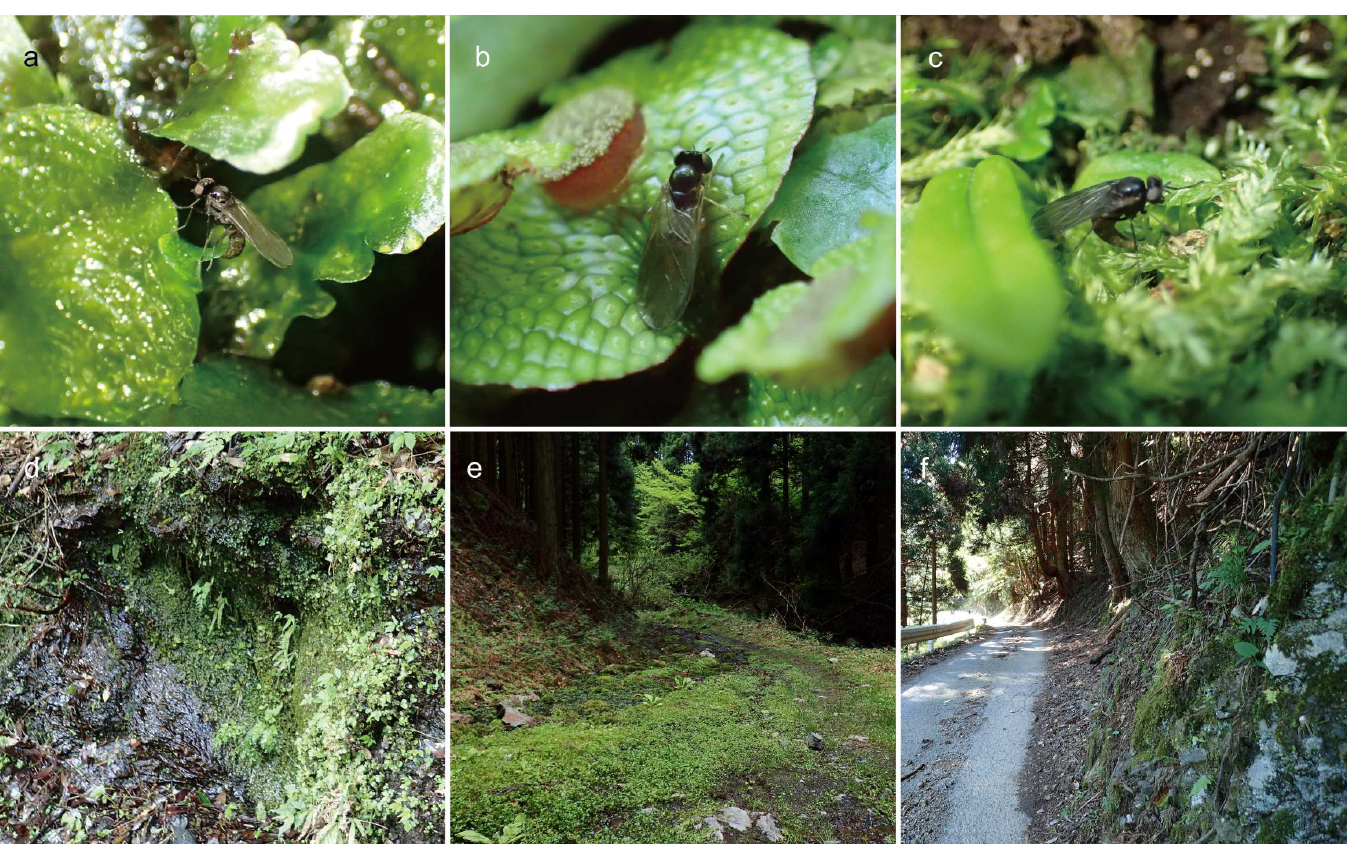
Fig 5. Ovipositing adult females and habitats of the bryophyte-feeders. Adult behaviors(a-c): (a) female of Spania sp. ovipositingon Pellia endiviifolia , at Higashiyoshinomura, Nara Pref., Japan; (b) female of Litoleptis japonica ovipositing on Conocephalum conicum , at Kibune, Kyoto Pref., Japan; (c)